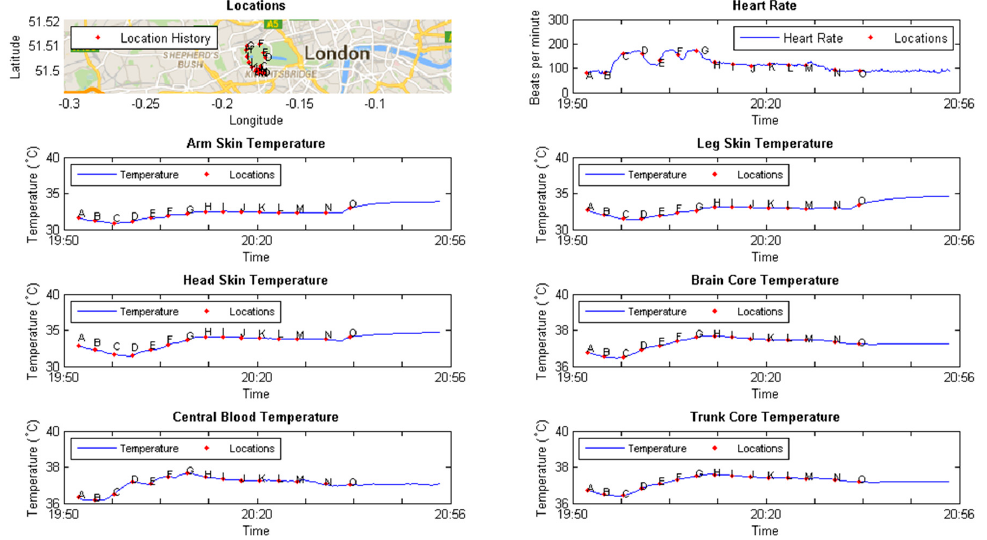
Figure 7. Analysis results from the proposed virtual sensing service containing location traces, heart rate measurements, and virtual temperature sensor readings of various parts of the body.